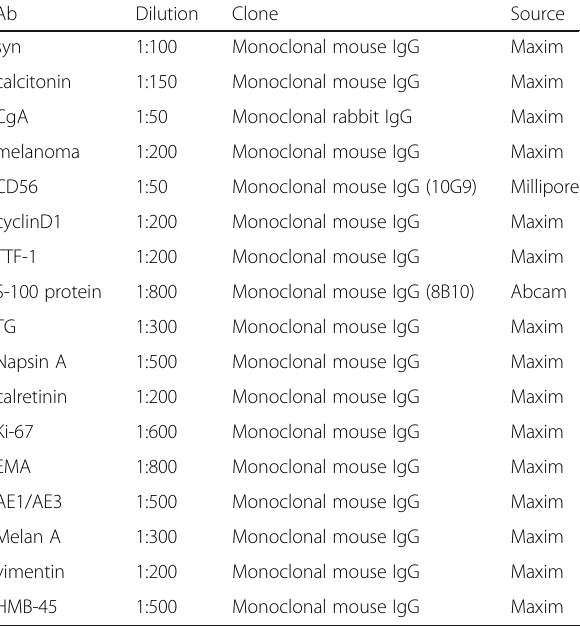
Table 1 Primary antibodies used in the study and their